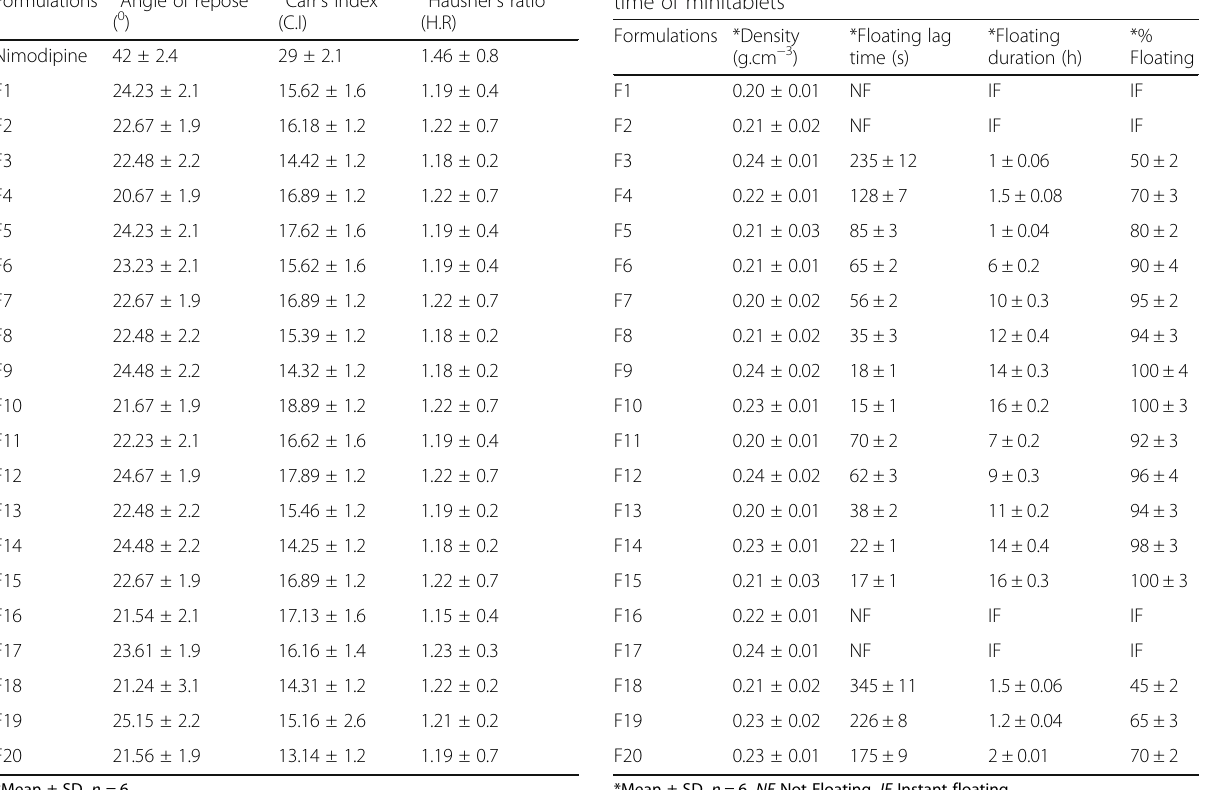
time of minitablets